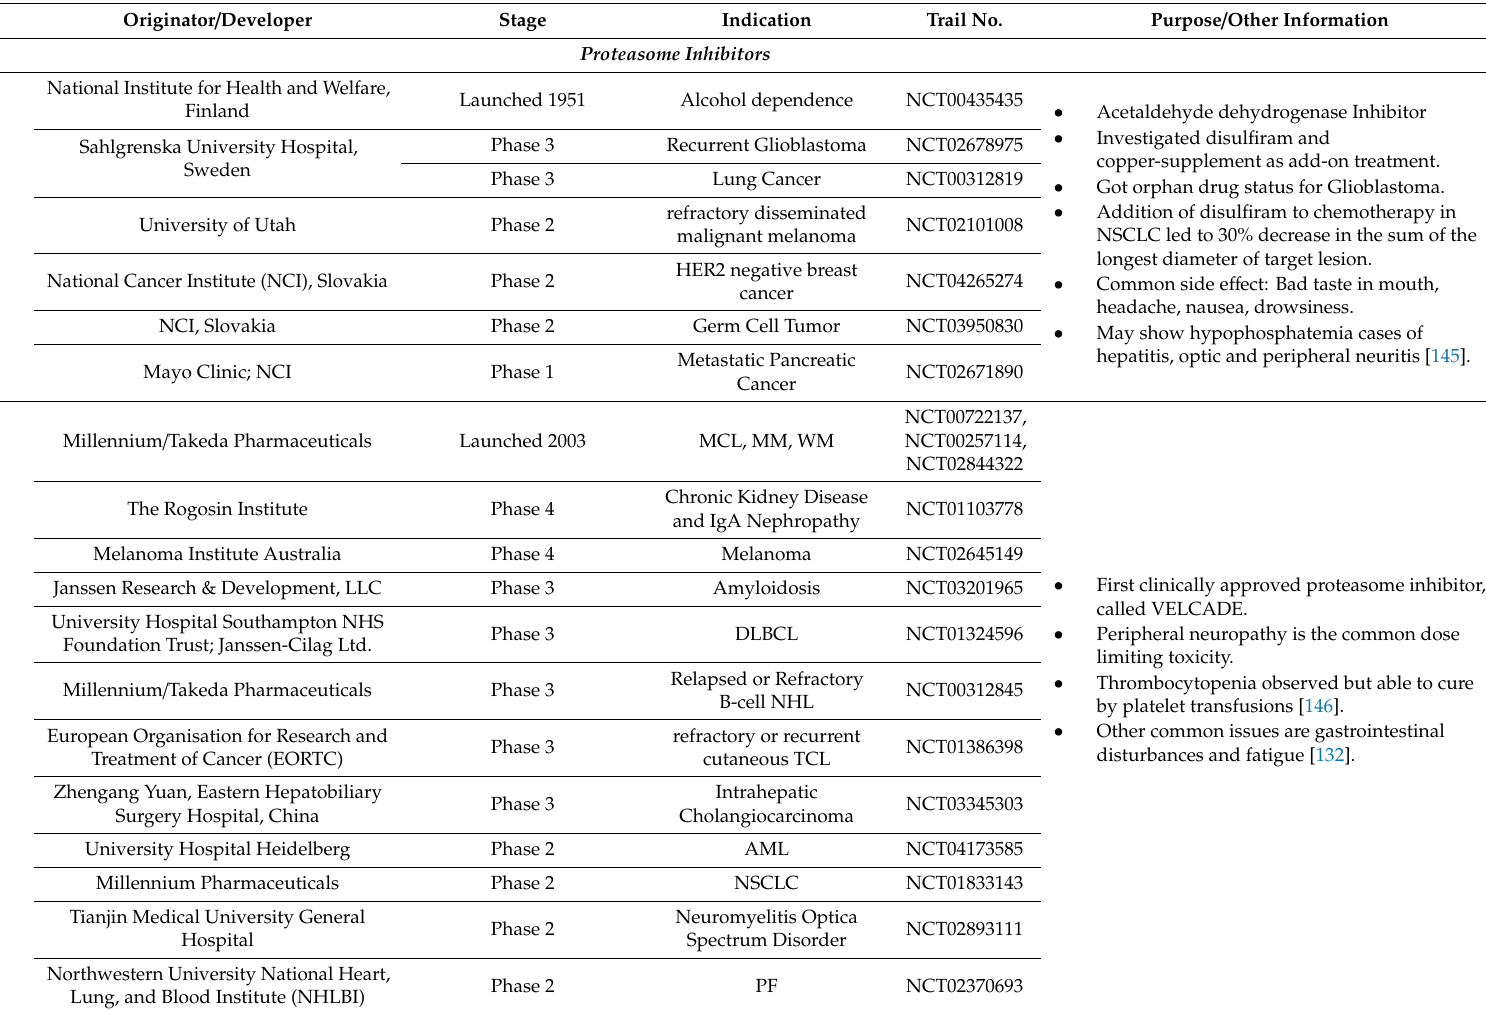
Table 4. Clinical small molecules inhibitors targeting Ubiquitin-Proteasome System (UPS) in NF- κ B